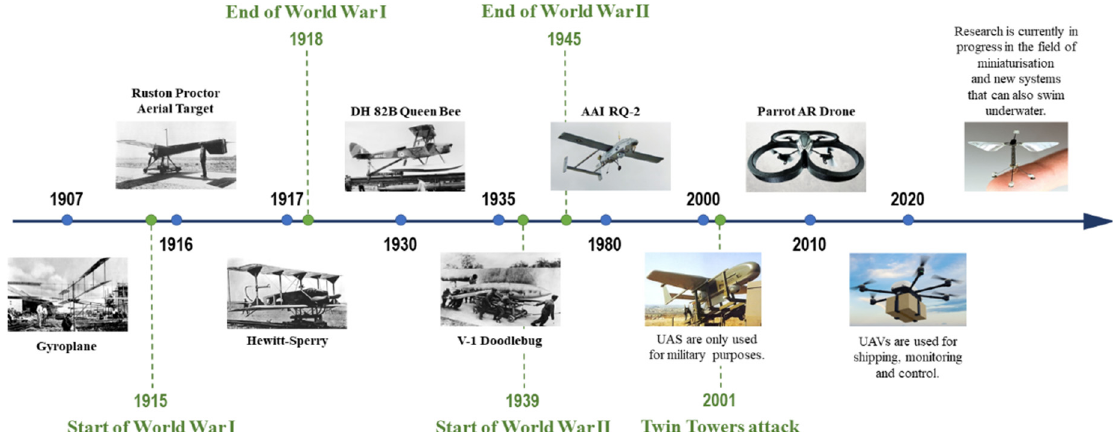
Figure 1. Historical evolution of drones.